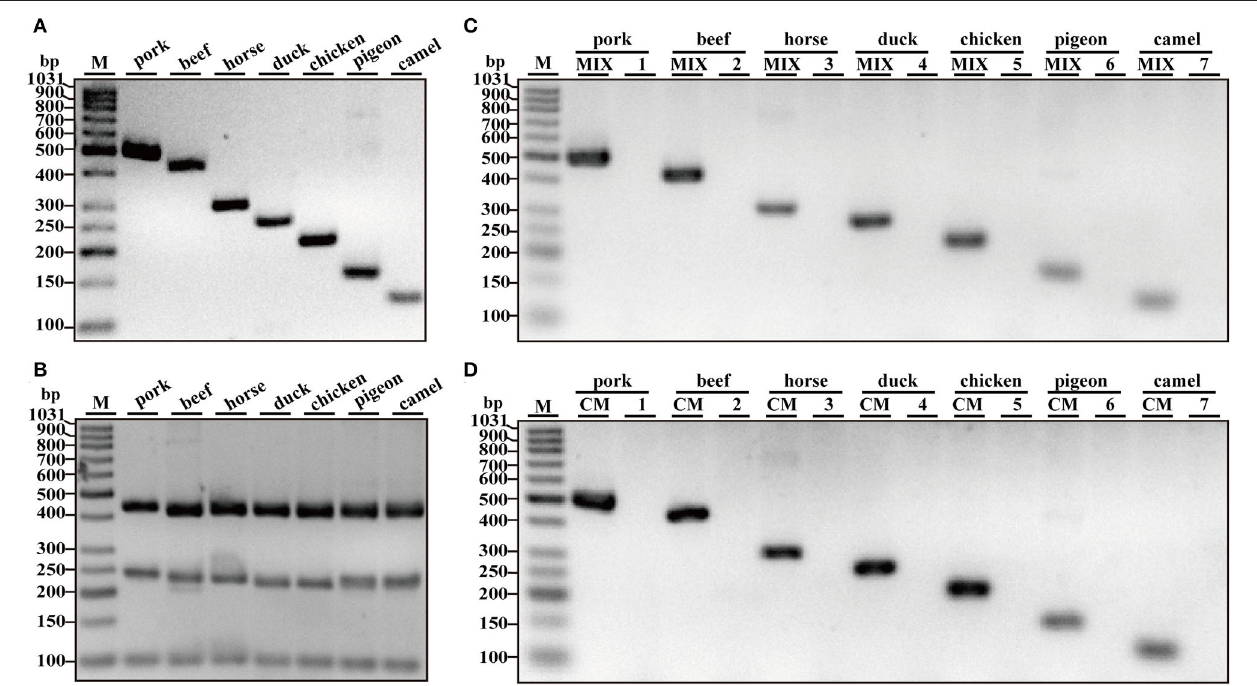
FIGURE 1 | Verification of primer specificity with conventional simplex PCR. (A) Simplex PCR detection using species-specific primers for camel, pigeon, chicken, duck, horse, beef, and pork origin and respective genomic DNA as a template. (B) PCR amplification with premixed universal primers of eukaryotic 12S rRNA, 16S rRNA, and 18S rRNA genes for each meat species, respectively. (C) PCR amplification using individual template DNA from camel, pigeon, chicken, duck, horse, beef, and pork species. MIX, a mixture of seven primer pairs of camel, pigeon, chicken, duck, horse, beef, and pork species; 1–7, a mixture of six primer pairs of six nontarget species. (D) PCR amplification with species-specific primers for camel, pigeon, chicken, duck, horse, beef, and pork species. CM, a complete mixture of seven species including camel, pigeon, chicken, duck, horse, beef, and pork; 1–7, a complete DNA mixture of six meat species except target species. Lane M is ladder